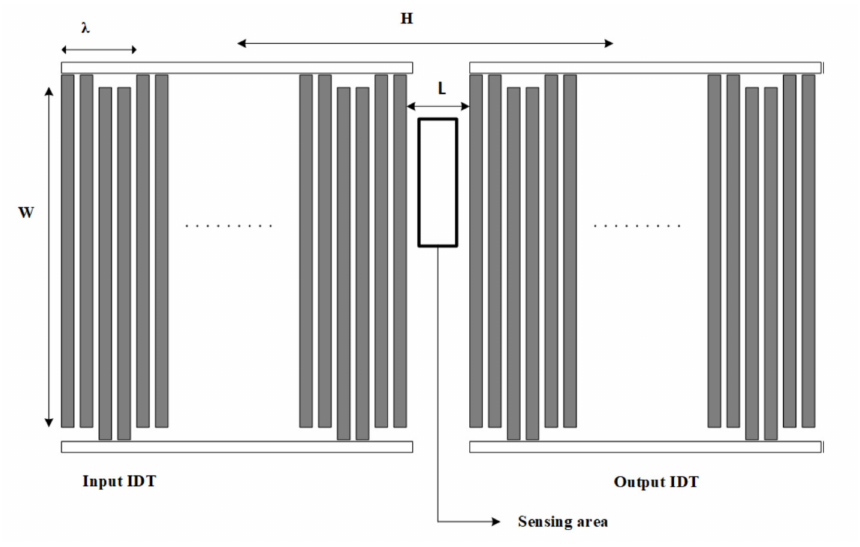
Figure 1. Surface acoustic wave (SAW) interdigital transducers (IDT) pattern.